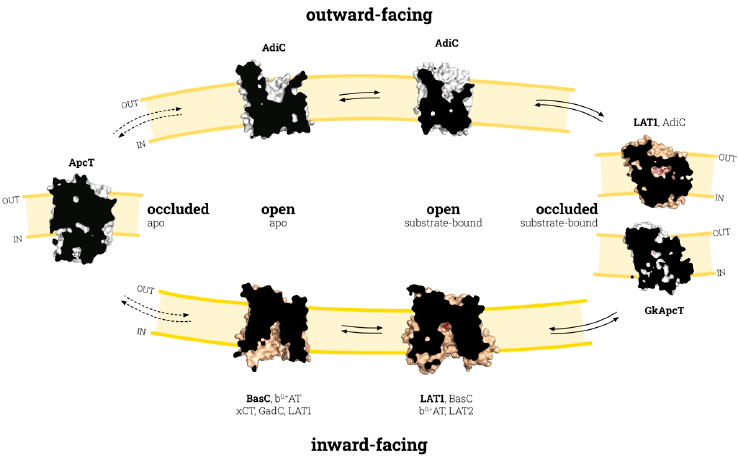
Figure 1. Conformational states of the APC family transport cycle. The transition between inward- and outward-facing states involves the occluded substrate-bound state (bold arrows), except for the transporters with a nonobligatory exchange activity, which could also explore the occluded apo state (dashed arrows). Each conformational state is shown by a sliced-surface representation of the transporter indicated in bold, colored gold for LATs and white for other APC transporters. All transporters with known structures in each state are indicated. PDB codes for the structures depicted here are the following: ApcT occluded apo (3GIA), AdiC outward-facing open apo (3NCY), AdiC outward-facing open substrate-bound (5J4N), human LAT1 and GkApcT outward-facing substrate-bound occluded (7DSK and 5OQT, respectively), human LAT1 inward-facing open substrate-bound (6IRT), and BasC inward-facing open apo (6F2G). The two occluded substrate-bound structures shown (hLAT1 and GkApcT) might represent small variations within the occluded substrate-bound state of LATs/CATs. Protein representations were created with PyMOL software (The PyMOL Molecular Graphics System, Version 2.3, Schrodinger, LLC. 2010).